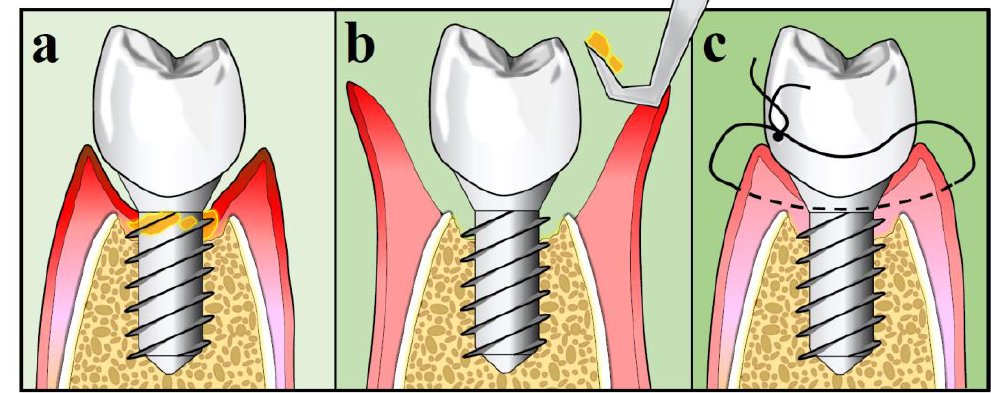
Figure 3. Open-flap debridement: ( a ) Pre-operative; ( b ) Intra-operative; ( c ) Flap closure.